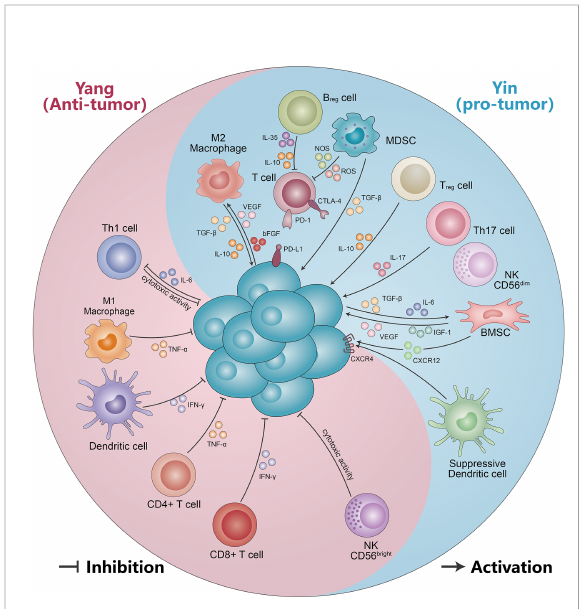
FIGURE 2 The yin and yang effects of immunity cells and non-cellular components. Immune cells (including CD56 bright NK cells, DC cells, CD4+ T cells, CD8+ T cells, M1-like macrophages, and Th1 cells) suppress malignant PCs by secreting IFN- g , TNF- a , and cytotoxic effects. Meanwhile, malignant PCs can form an immunosuppressive microenvironment (including M2-like macrophages, MDSC, Treg cells, Th17 cells, suppressor DC cells, CD56 dim NK cells, and Bregs) by secreting IL-10, TGF- b , and IL-6. The immunosuppressive microenvironment in turn can be suppressed by VEGF, IL-17, IGF-1, IL-10, and TGF- b , which promotes multiple myeloma progression. See text for detailed